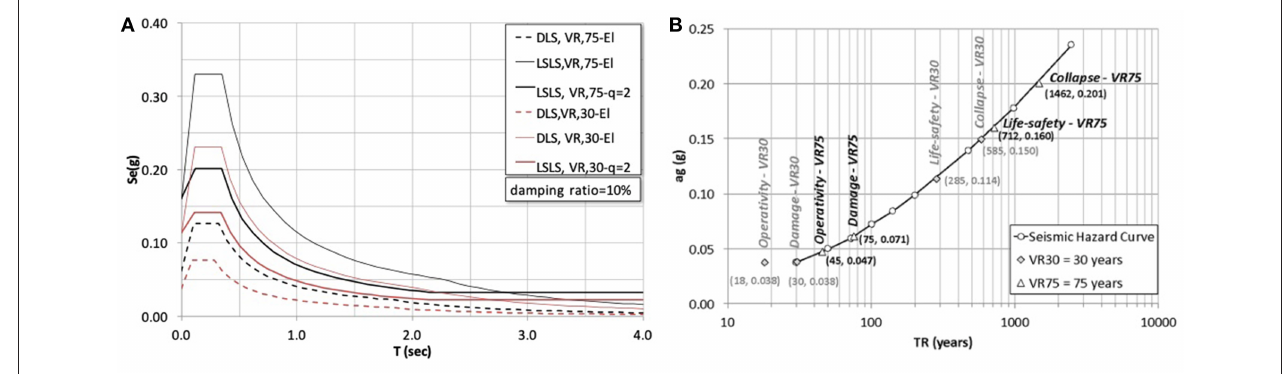
FIGURE 2 | (A) Spectra of the horizontal seismic action corresponding to DLS and LSLS (B) Seismic Hazard of the site (in semi-logarithmic scale).